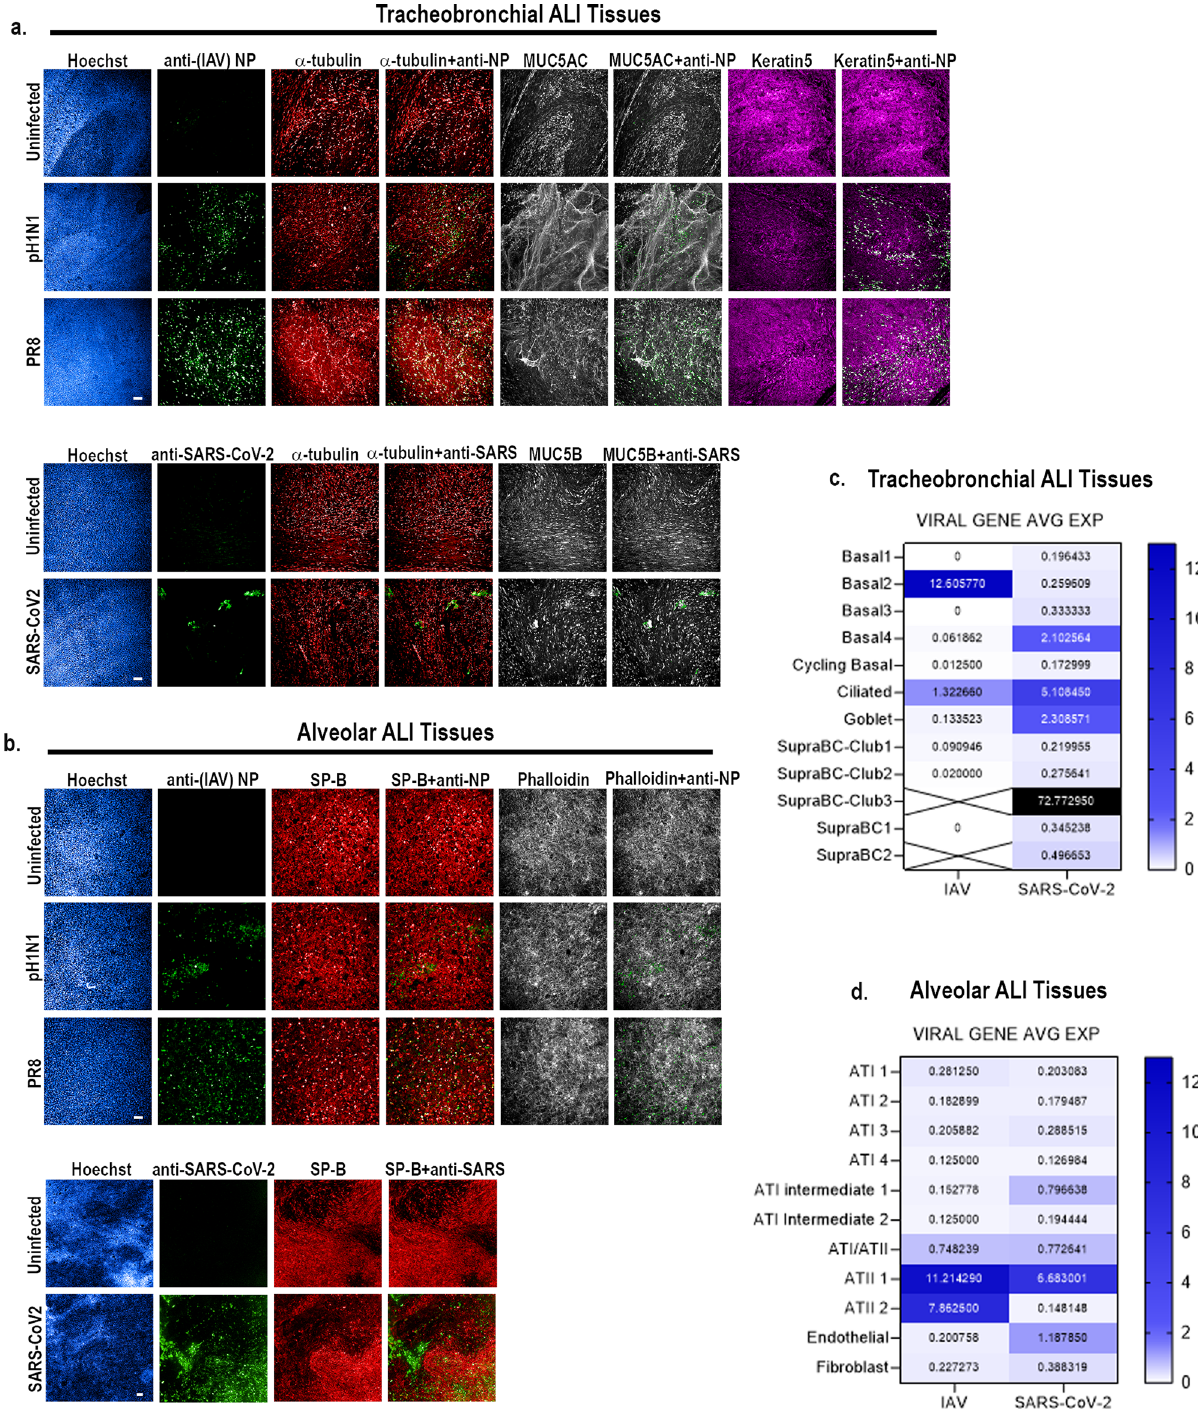
Fig. 2 IAV and SARS-CoV-2 productively infect tracheobronchial and alveolar ALI tissue equivalents. Tracheobronchial and alveolar ALI tissues were infected with IAV strains pH1N1 or PR8 (1x10e5 TCID 50 units), or SARS-CoV-2 (1x10e5 TCID 50 units), ( n = 3). Infected tissues were fi xed at 24 hpi for IAV inoculated tissue, 36 hpi for SARS-CoV-2 inoculated tracheobronchial ALI tissue, or 144 hpi for SARS-CoV-2 inoculated alveolar ALI tissue and stained with antibodies against selected cell markers and virus antigens as indicated: a Tracheobronchial ALI tissues were stained with anti-(IAV) NP (green, top three panels) or anti-SARS-CoV-2 (monoclonal antibody cocktail targeting S and N proteins, green, bottom two panels), anti- α -tubulin (ciliated cell marker, red), anti-MUC5AC or MUC5B (goblet cell markers, white), and anti-keratin 5 (basal cell marker, magenta). b Alveolar tissues were stained with anti-(IAV) NP (green top three panels) or anti-SARS-CoV-2 (green, bottom two panels) as the marker of infected cells as well as anti-surfactant protein B (SP-B, ATII cell marker, red), phalloidin (F-actin, general cell marker, white). Scale bar is 100 μ m and 200 μ m in IAV and SARS-CoV-2 infected tissues, respectively. Viral gene expression levels, expressed as log transform mean expression, in identi fi ed cell subpopulation types within the human ( c ) tracheobronchial or ( d ) alveolar ALI tissues after 48 h of infection with PR8-IAV (left column), or after 72 h of infection with SARS-CoV-2 (right column). Identi fi ed viral genes per cell type were averaged and plotted as average log mean